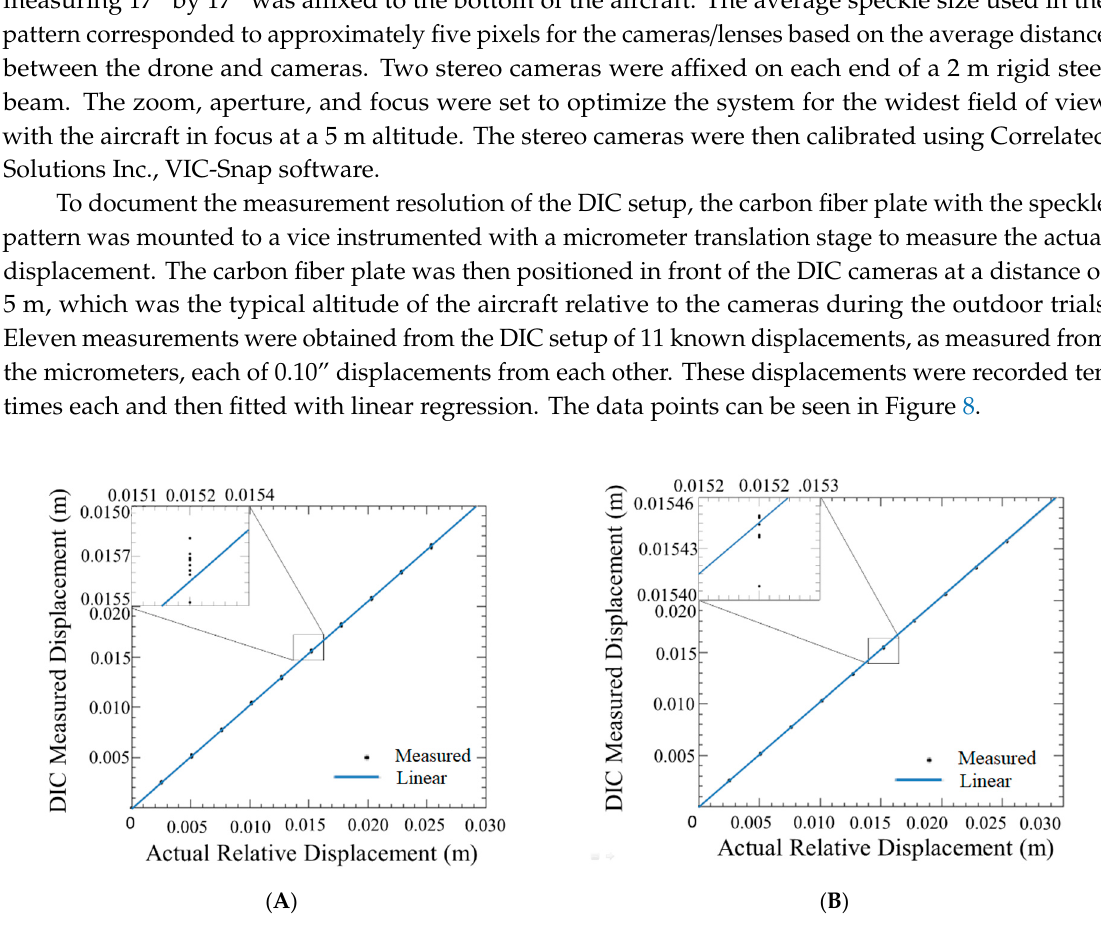
Figure 8. DIC measurement resolution results: ( A ) Out-of-plane direction; ( B ) In-plane direction. The displacement measurements were made in the out-of-plane direction (Z direction corresponding to altitude) and the in-plane direction (X-Y direction). It was found that the standard error for the DIC measurements versus out-of-plane for in-plane and out-of-plane measurements came out to be 0.02059 mm and 0.06796 mm respectively. Due to the standard error being so small, the resolution for all the plots obtained from these experiments can conservatively be estimated to be smaller than the line thickness used. The high measurement resolution compared to typical fiducial